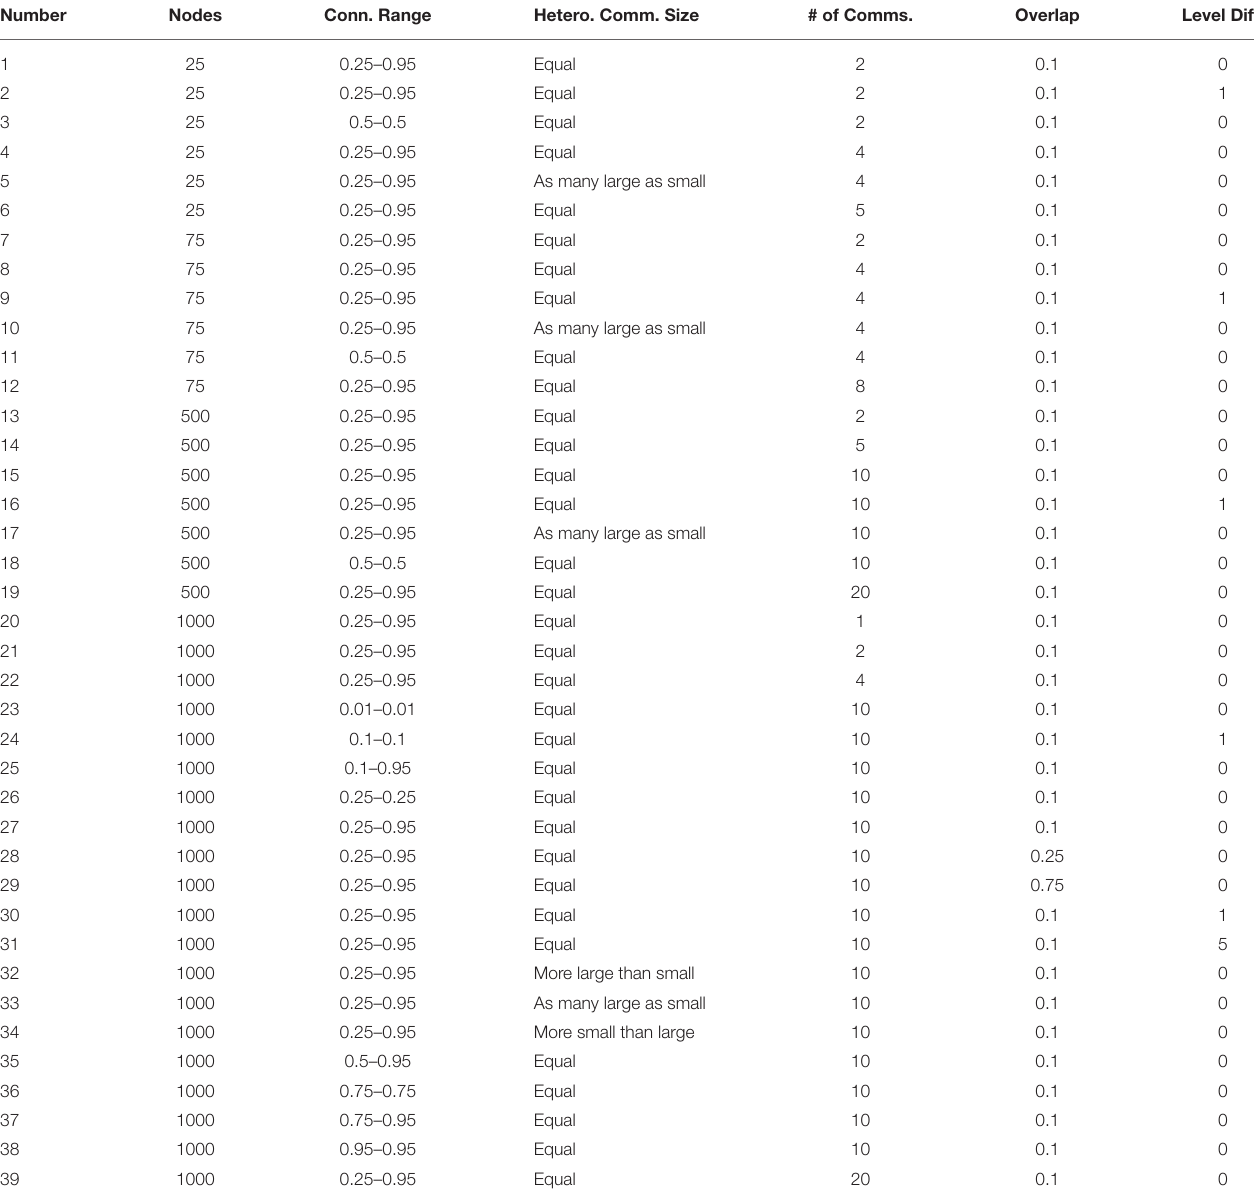
TABLE 3 | Correlation and euclidean distance